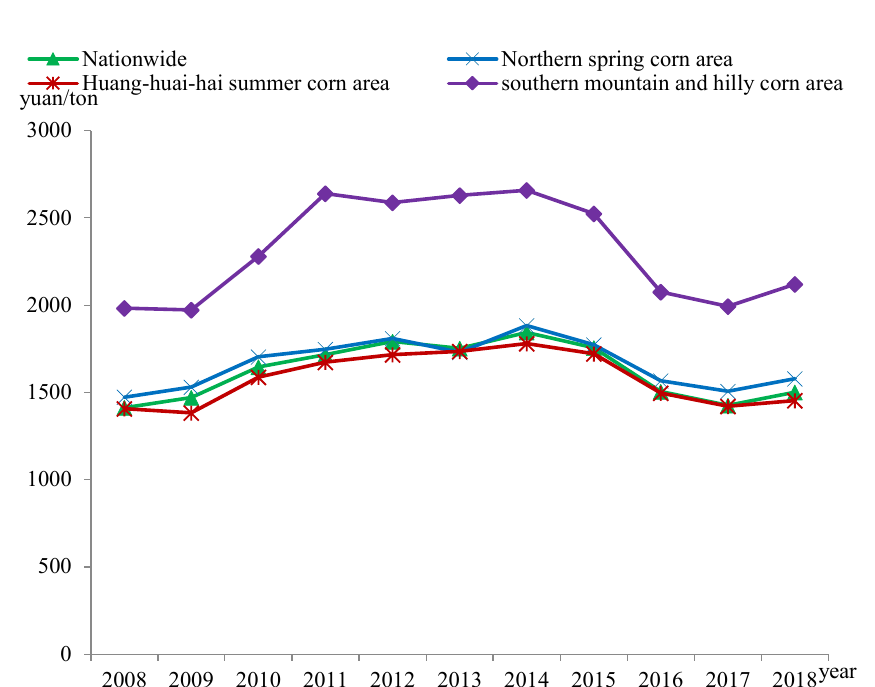
Figure 1. Corn production cost of China and three major corn producing areas from 2008 to 2018.